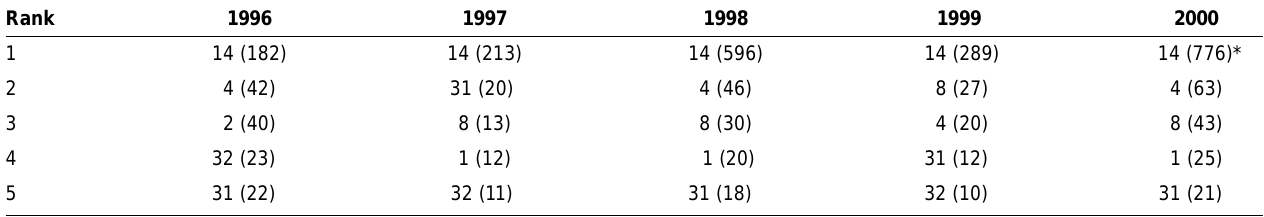
TABLE 7 The five most common Escherichia coli O157:H7 phage types (PTs) identified by the Canadian National Laboratory for Enteric Pathogens from human isolates, 1996 to